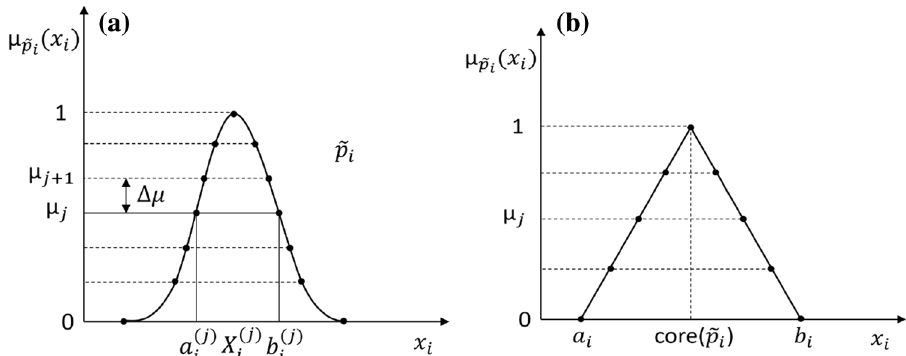
Fig. 1 Fuzzy number ̃ p i with 𝛼 -cuts according to [18], ( a ) general ( b )